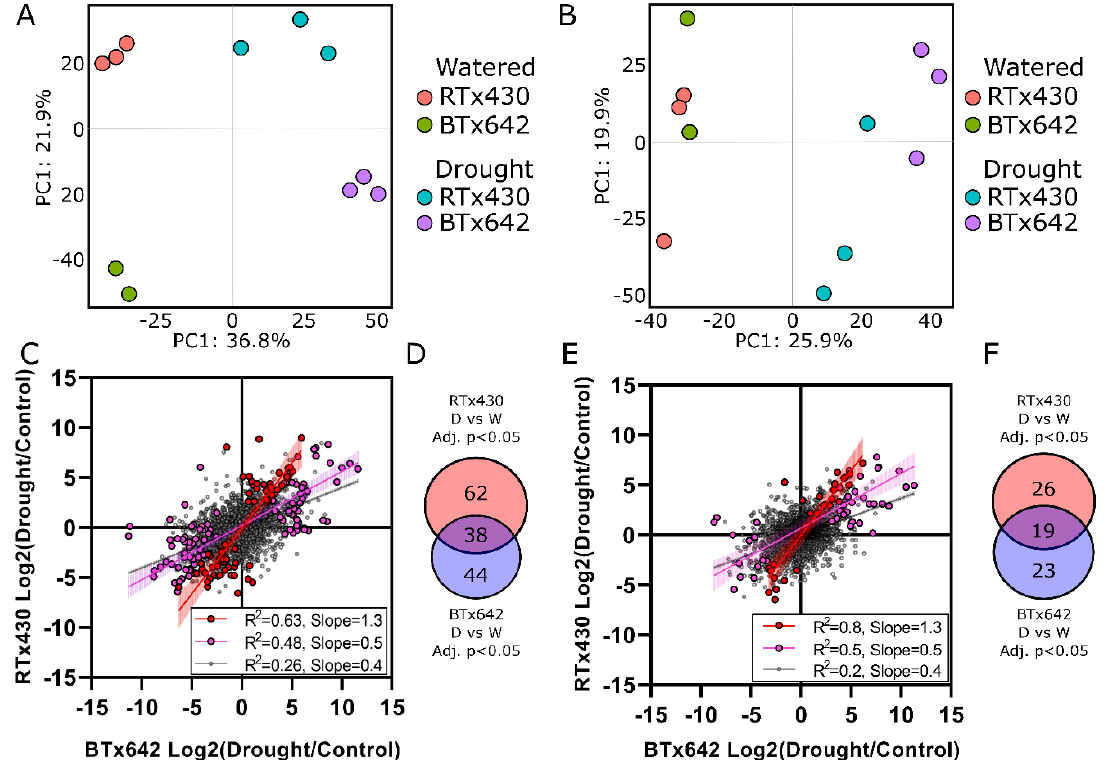
Figure 2. Principal component analysis of organelle- ( A ) and cytosolic-enriched protein profiles ( B ) in response to drought. Correlation between RTx430 and BTx642 drought responses in ( C ) organelle- and ( E ) cytoplasm-enriched samples. Venn diagram summary of proteins with adj. p -value < 0.05 in each genotype for ( D ) organelle- and ( F ) cytosolic-enriched samples. Purple data points are significantly changed in either genotype, while red points correspond to RTx430-specific changes (adj. p -value < 0.05). D, Drought; W, Watered; PC, Principal Component.